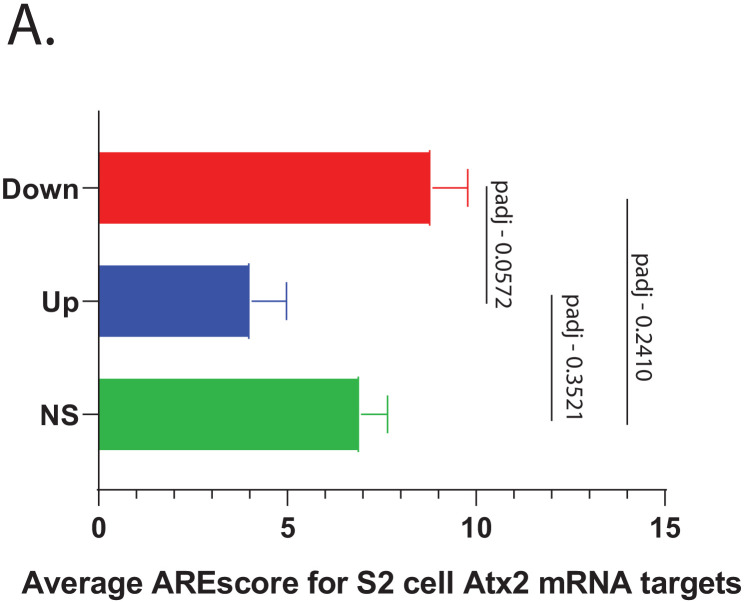
AREScore correlate directly with the stability of Atx2-target mRNAs in S2 cells.